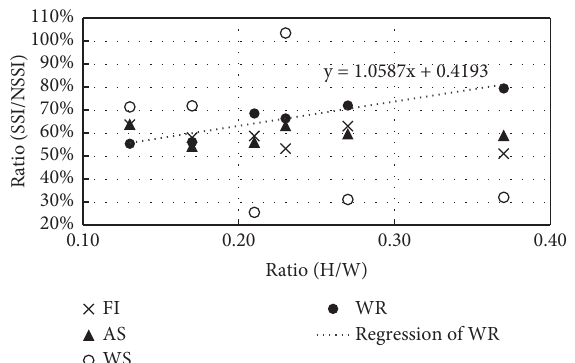
Figure 13: Distribution of correlation between H / W ratio and SSI/ NSSI